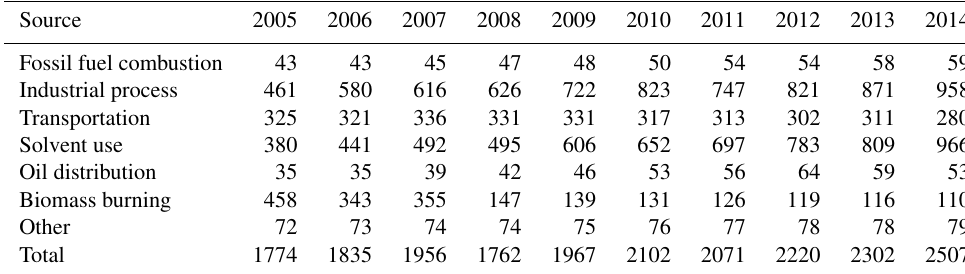
Figure 1. NMVOC source profiles by grouped species measured in chemical enterprises (a) and the comparisons with SPECIATE results for synthetic rubber (b) , ethylene (c) and polyethylene production (d) . Table 3. Anthropogenic NMVOC emissions in Jiangsu by source from 2005 to 2014